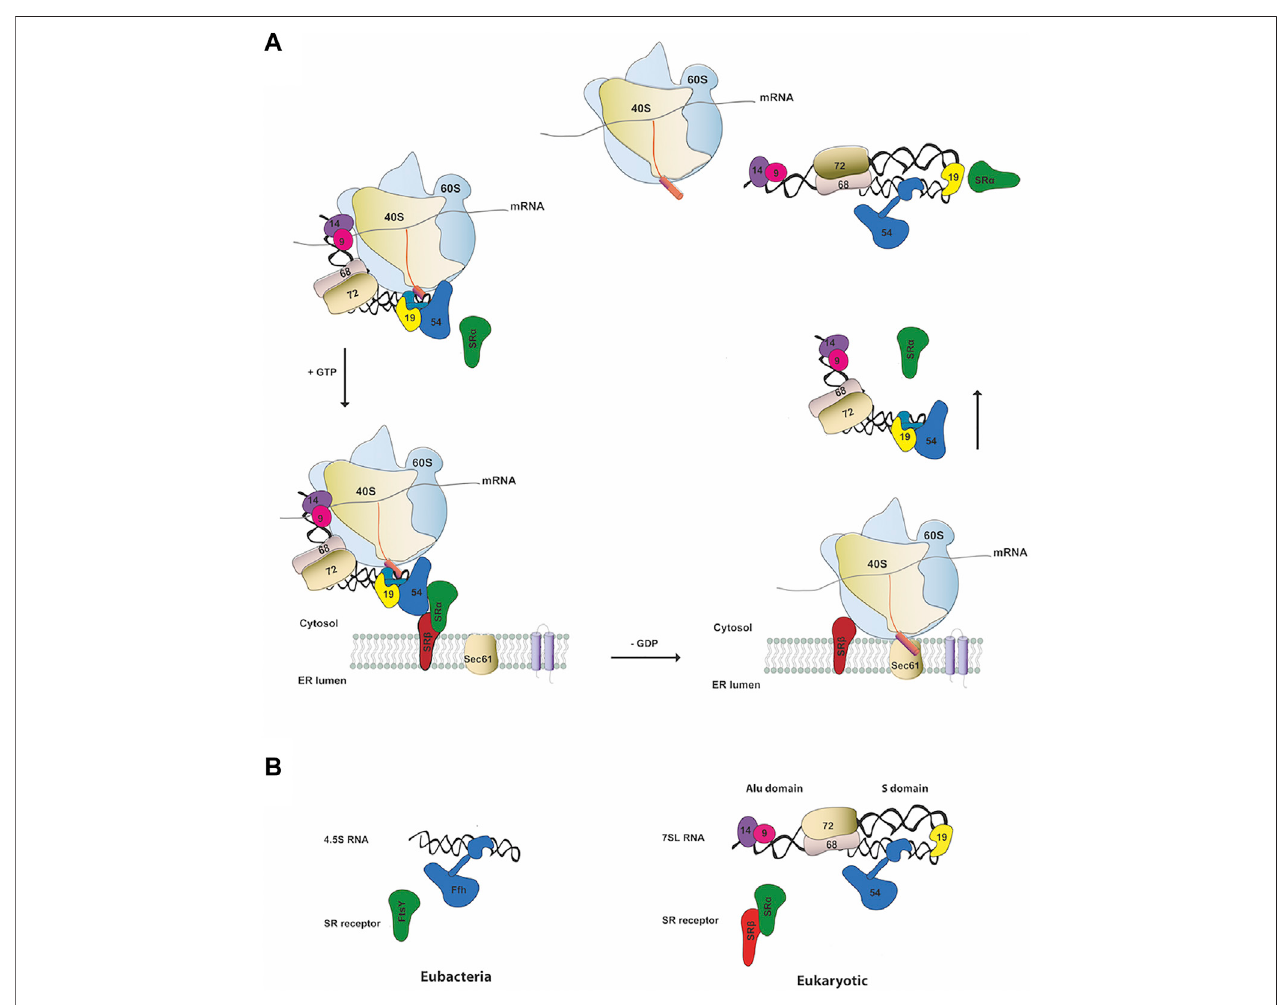
FIGURE 1 | SRP canonical cycle and composition (A) Schematic representation of co-translation protein targeting pathway in mammals. SRP binds the signal sequence (pink cylinder) as it emerges from the ribosome forming an RNC-SRP complex that docks in a GTP-dependent manner with the ER membrane by binding to the cognate SRP receptor (SR α / β ). Following GTP hydrolysis, the RNC is transferred to the Sec61 translocon resulting in translocation of the nascent chain through the Sec61 pore and disassemble of SRP-SR complex (B) Schematic representation of SRP and SR components in the two kingdoms of life. On the left panel it is shown the eubacterial SRP complex and on the right the eukaryotic one (e.g., human